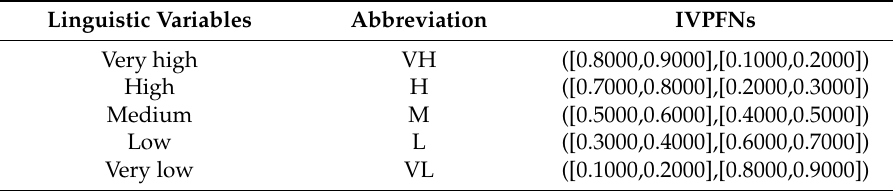
Table 1. Linguistic terms for rating the weights of risk factors [49].